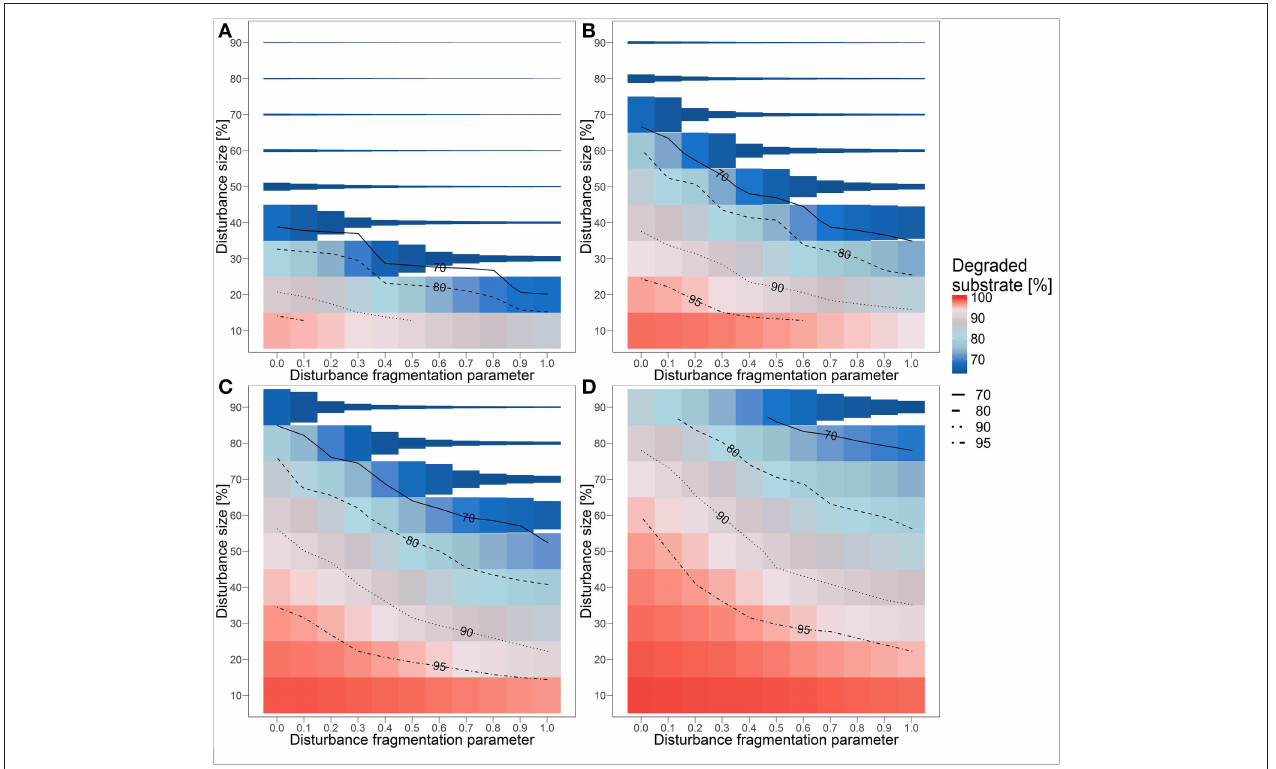
FIGURE 5 | Functional resistance under recurrent disturbance events with a disturbance return interval of (A) 10h, (B) 25h, (C) 50h, and (D) 100h. Colors represent substrate degradation within 4,000h of simulation time in relation to the undisturbed reference degradation performance (indicated by 100%). Height of boxes indicates time to collapse relative to maximum simulation time of